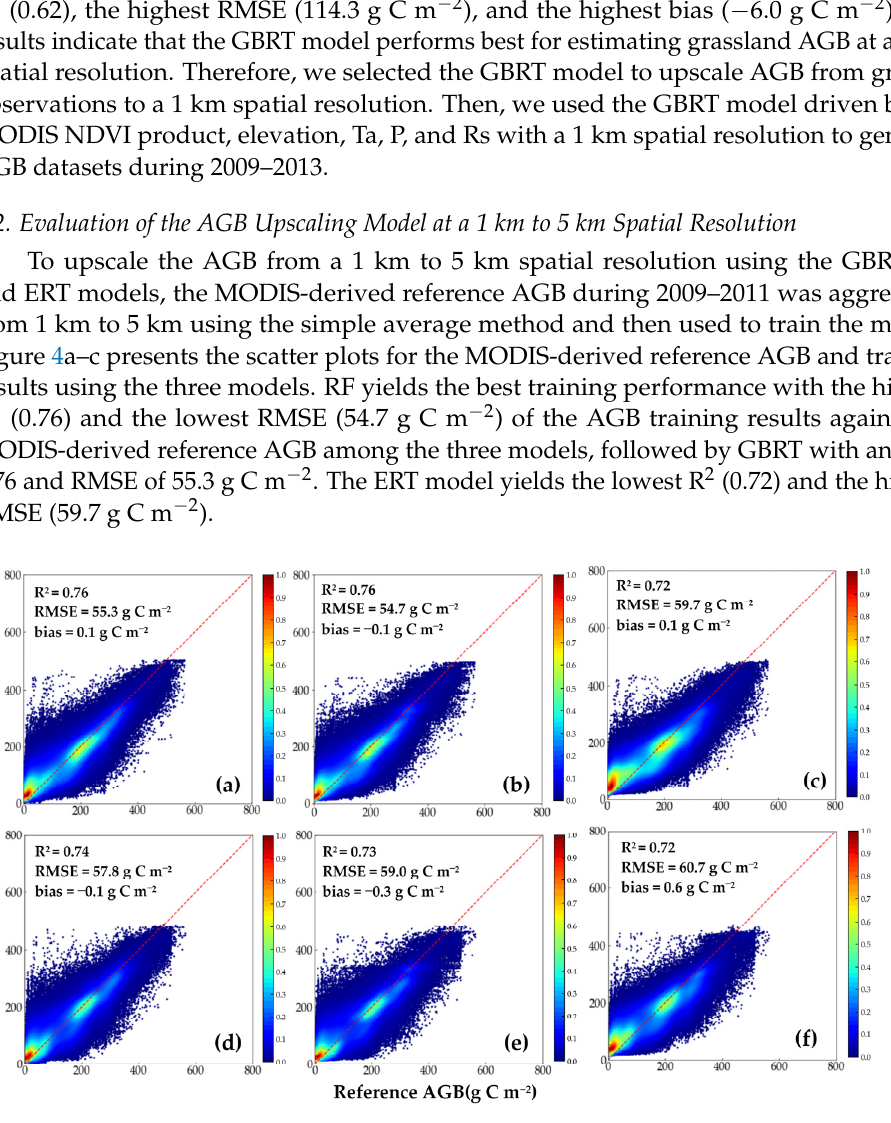
Figure 4. Scatter plots for MODIS-derived reference and AVHRR-derived estimated AGB with 5 km spatial resolution from ( a ) GBRT, ( b ) RF, ( c ) ERT in training set and ( d ) GBRT, ( e ) RF, ( f ) ERT in validation set.